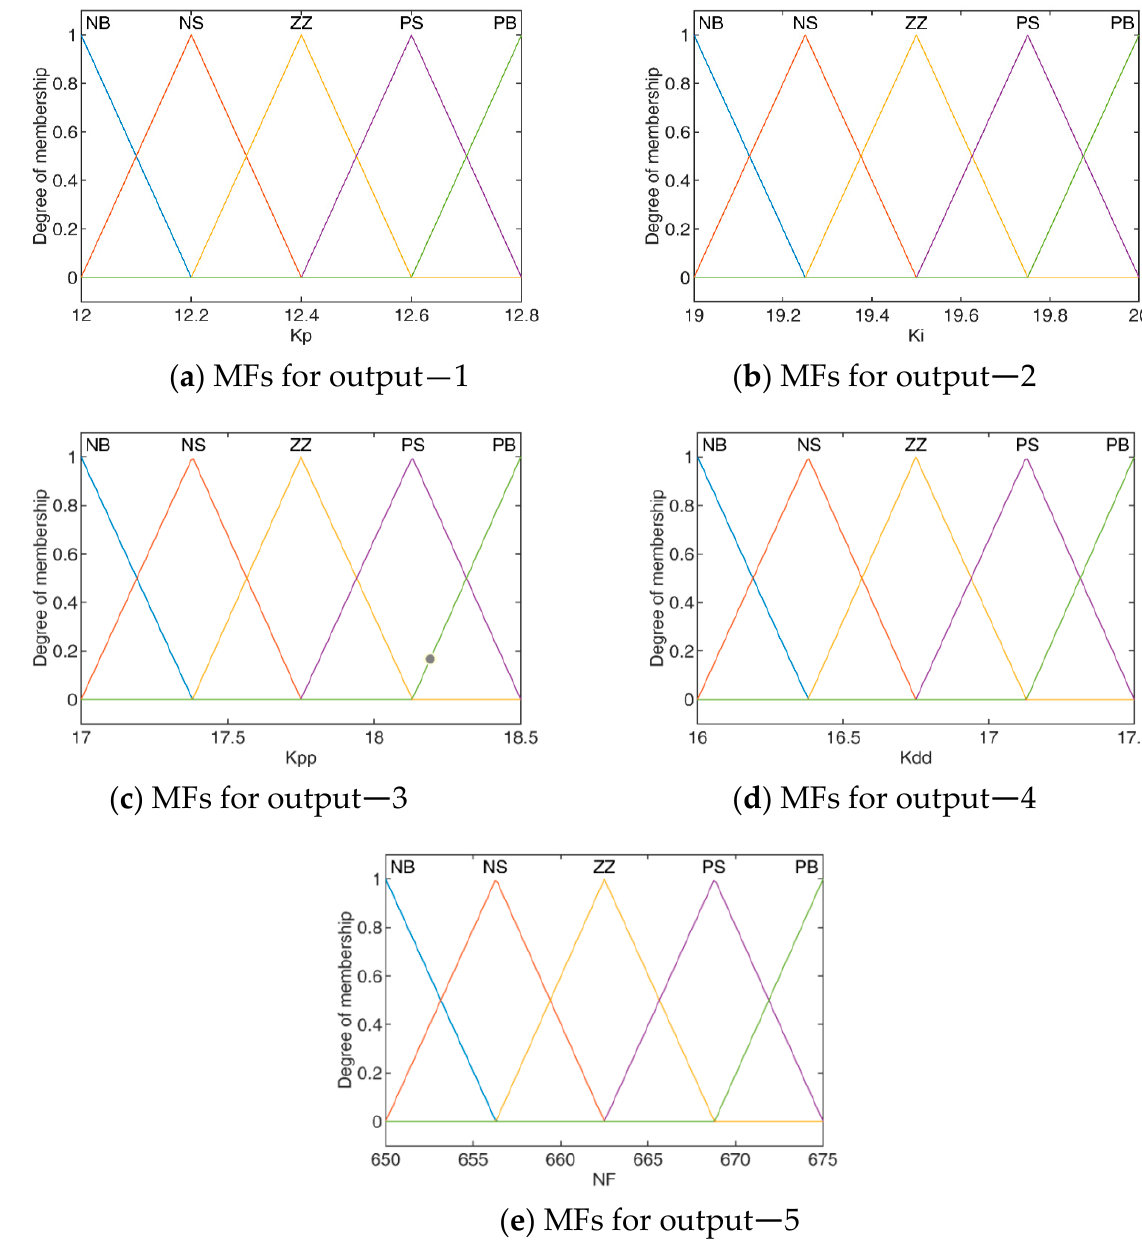
Figure 7. Output MFs of fuzzy system.